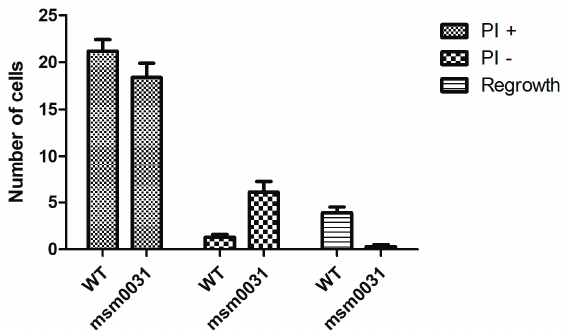
Figure 6. Phenotypic subpopulations of INH-exposed M. smegmatis wild-type and the msm0031::Tn mutant cells. The mean values show the number of cells, the error bars show the standard errors of ten different points in the microfluidic device. PI stands for propidium iodide staining. PI +: PI stained cells, PI-: PI-free cells.